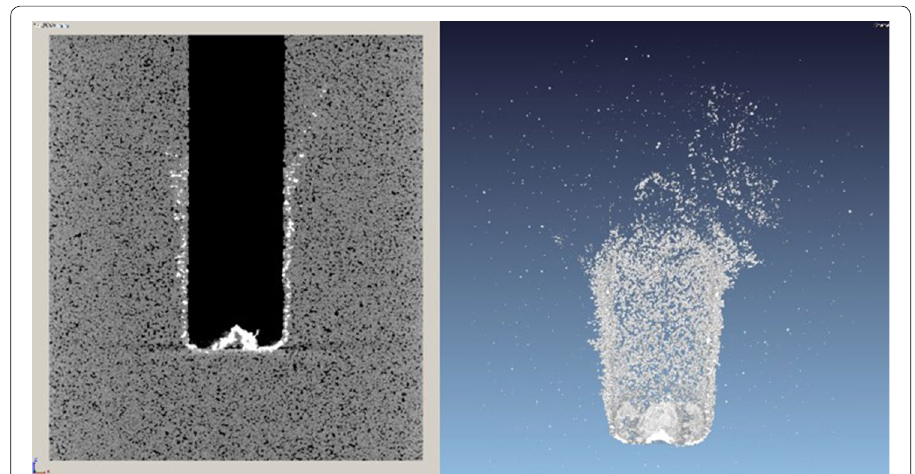
Fig. 6 Computer tomographic (CT) images of one rock sample after the flow-through experiment (Experi- ment C; 80 °C). White areas indicate precipitation of a high-density material in the pores of the rock. Left 2D,